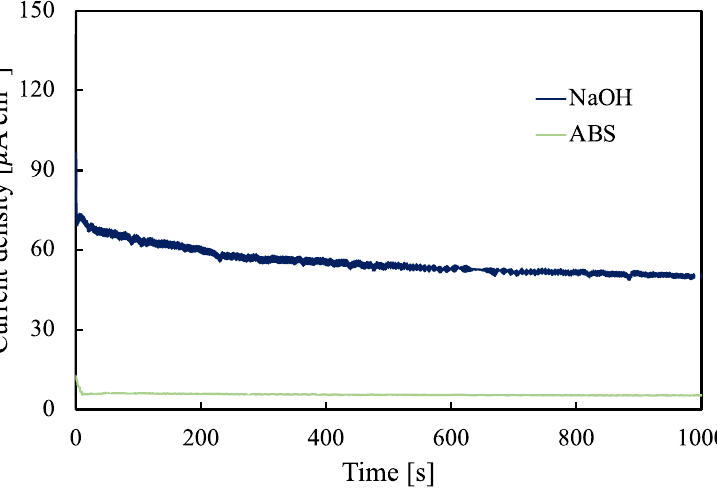
Figure 8. Leakage current measurement for the anodic oxides grown on Ta-66at%Nb alloy in NaOH and ABS solutions at 50 V by applying 37.5 V for 1000 s.